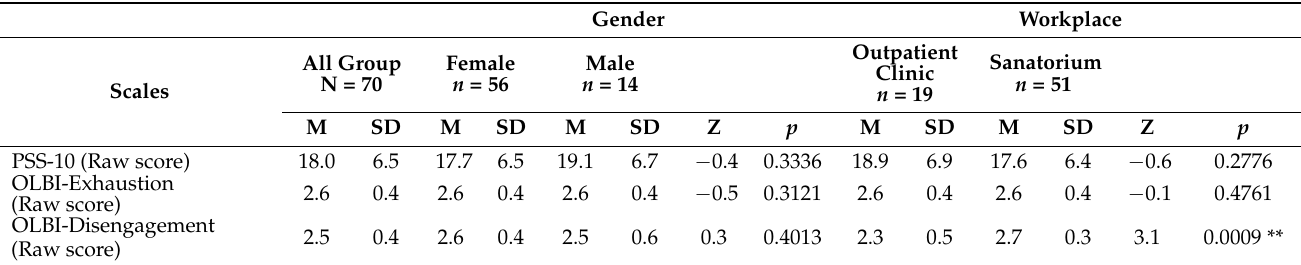
Table 3. The PSS-10 and the OLBI results in the study group of physiotherapists and in selected subgroups (the Mann– Whitney U